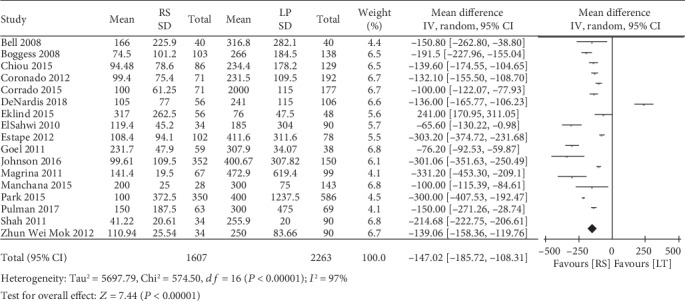
Forest plot of EBL between the RS and LT groups.